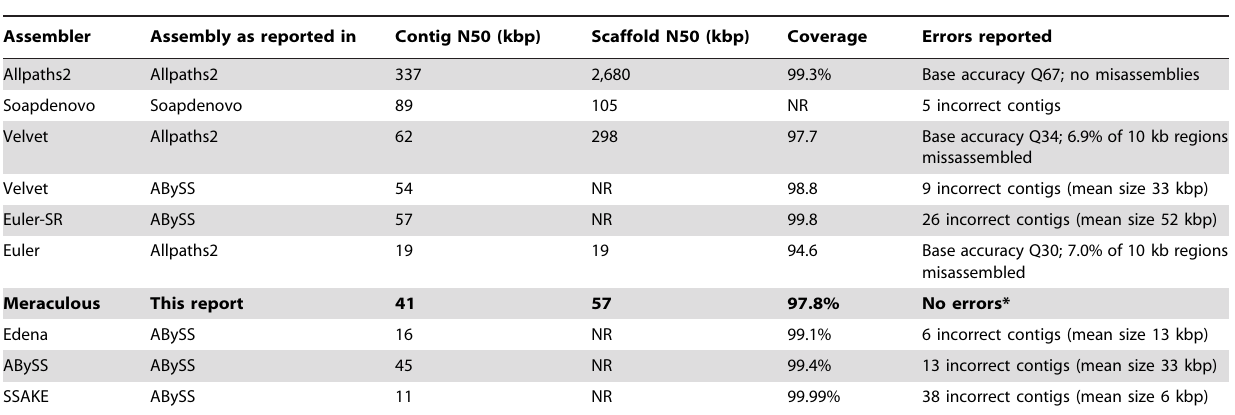
Table 1. Comparison of assembles of E. coli K12 MG1655 benchmark